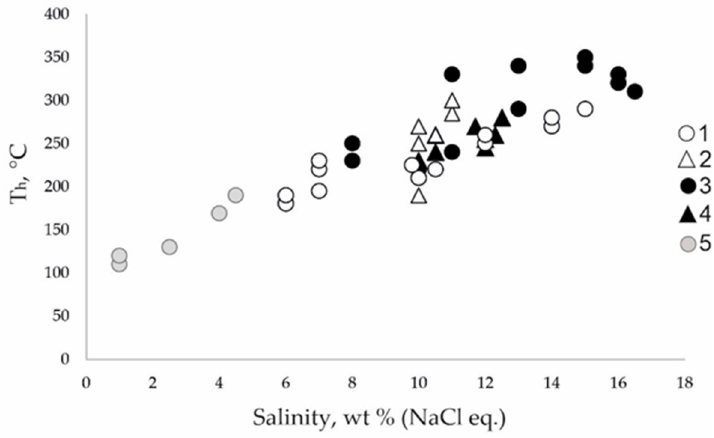
Figure 7. Homogenization temperature (T h ) vs. salinity plot for fluid inclusions in quartz of pre–ore (1—type A, L H2O + V; 2—type B, L H2O + L(V) CO2 ± CH4 ± N2 ), ore (3—type A, L H2O + V, 4—type B, (1—type A, L H2O + V; 2—type B, L Н 2 О + L(V) СО 2 ± СН 4 ± N2 ), ore (3—type A, L H2O + V, 4—type B, L Н 2 О + L H2O + L(V) CO2 ± CH4 ± N2 ) and post-ore (5—type A, L H2O + V) L(V) СО 2 ± СН 4 ± N2 ) and post–ore (5—type A, L H2O + V) stages.